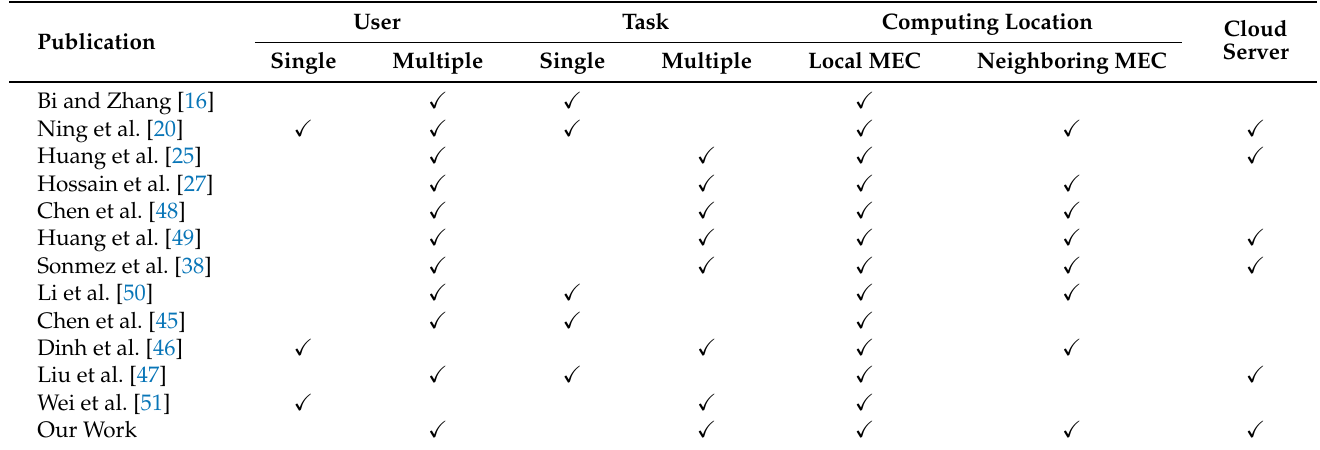
Table 7. Summary of different task offloading in MEC-enabled networks.